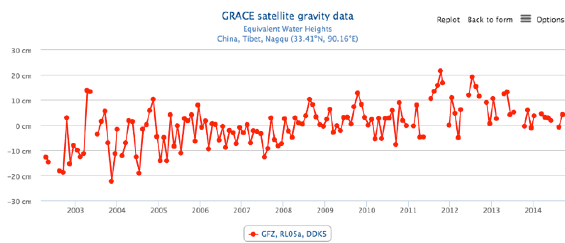
Figure 4. Mass change measured by GRACE and presented in EWH. The time series is generated by the GRACE plotter service provided by CNES. The data used here is monthly solution released by